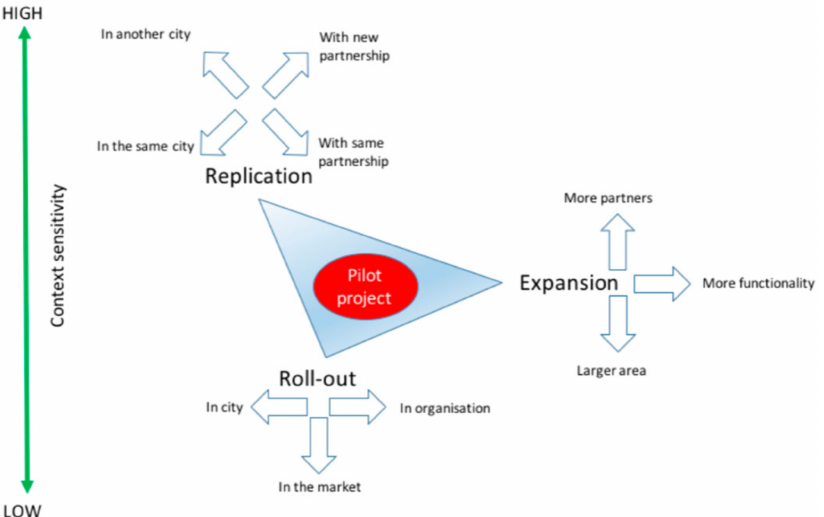
Figure 3. Types of upscaling. Reprinted from Ref. [3], Winden (2016, p.